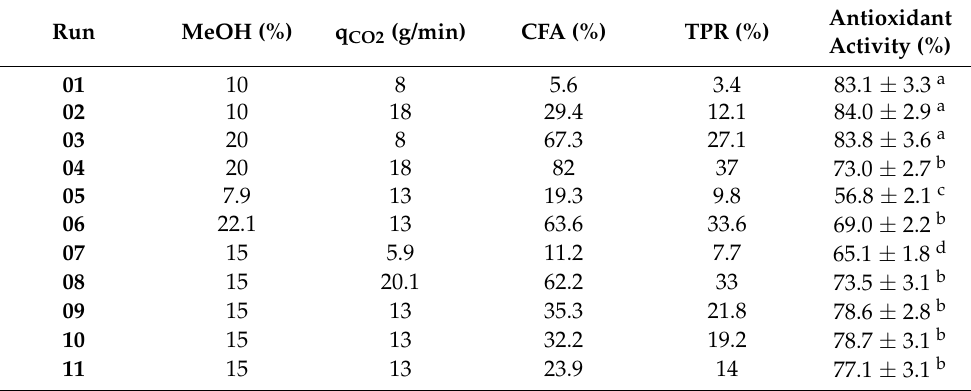
Table 4. Experimental conditions for the optimization study regarding the supercritical fluid ex- traction (SFE) of potato peels. The responses were analyzed as a function of % of total phenolic recovery (TPR), caffeic acid recovery, and antioxidant activity. Fixed independent variables: T: 80 ◦